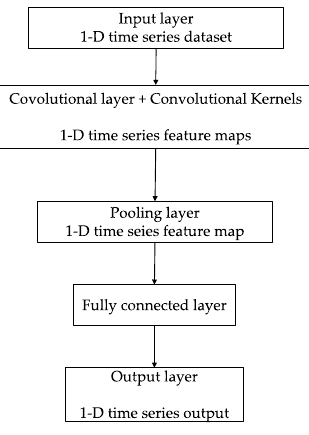
Figure 2. Architecture of a 1-D CNN network.